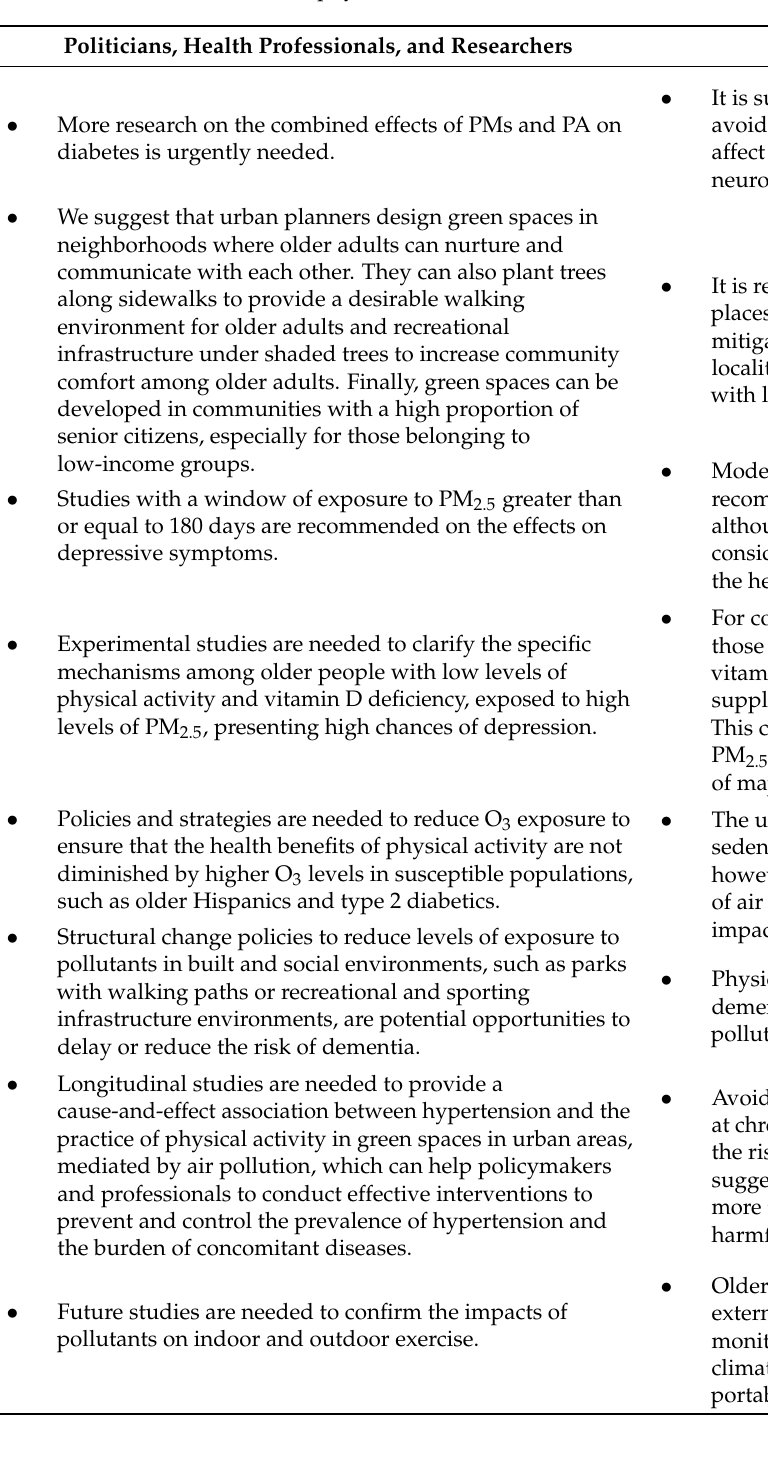
Table 8. Recommendations for policymakers, health professionals, researchers, and practitioners of physical